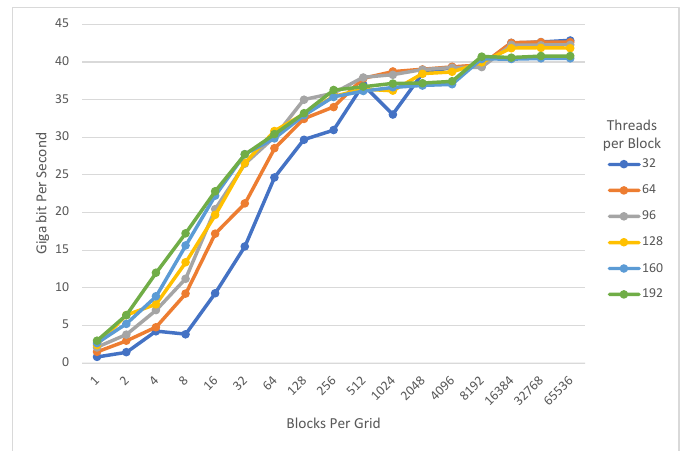
Figure 10. GIFT-64 encryption: Comparison of the number of encryption per second.